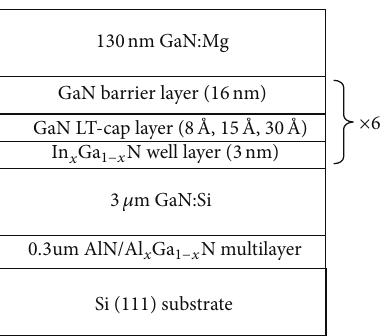
Figure 1: Epilayer structure of green InGaN/GaN light emitting diodes on silicon (111) substrate.